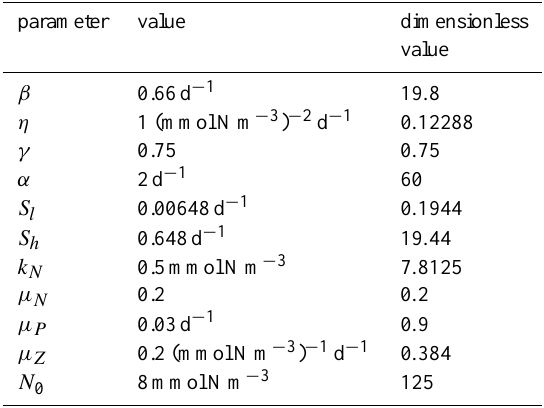
Table 1. List of parameters used in the NPZ model, Eqs. (6–8).